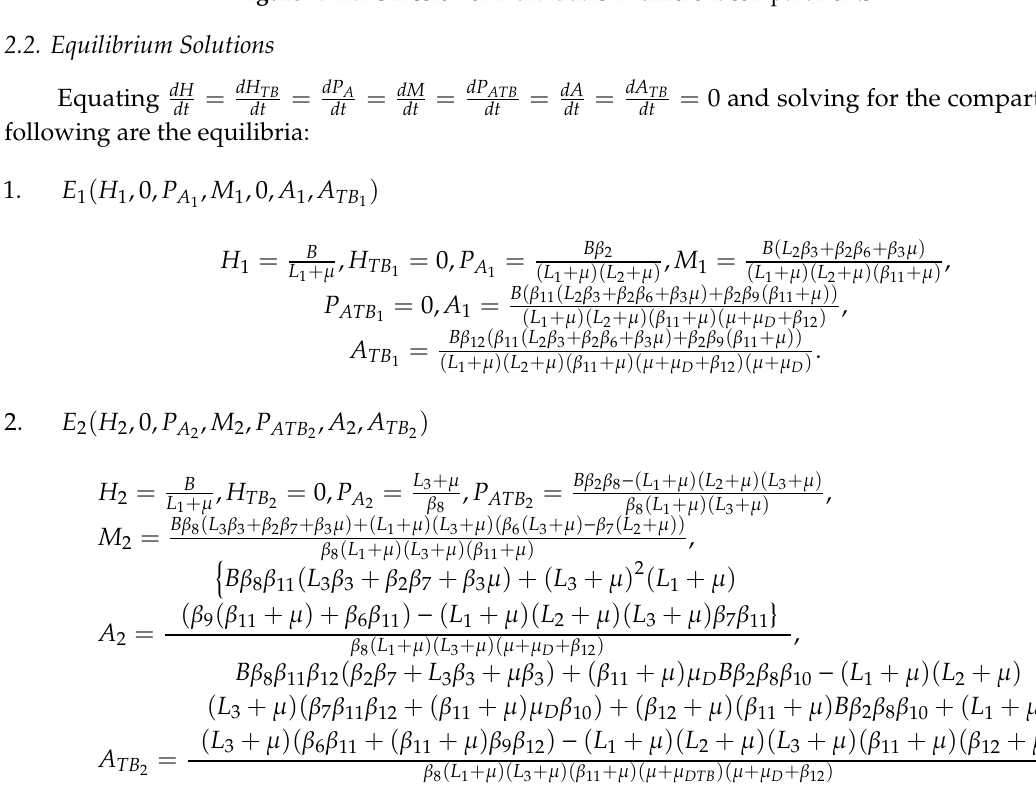
Figure 1. Transmission of individuals in different compartments.